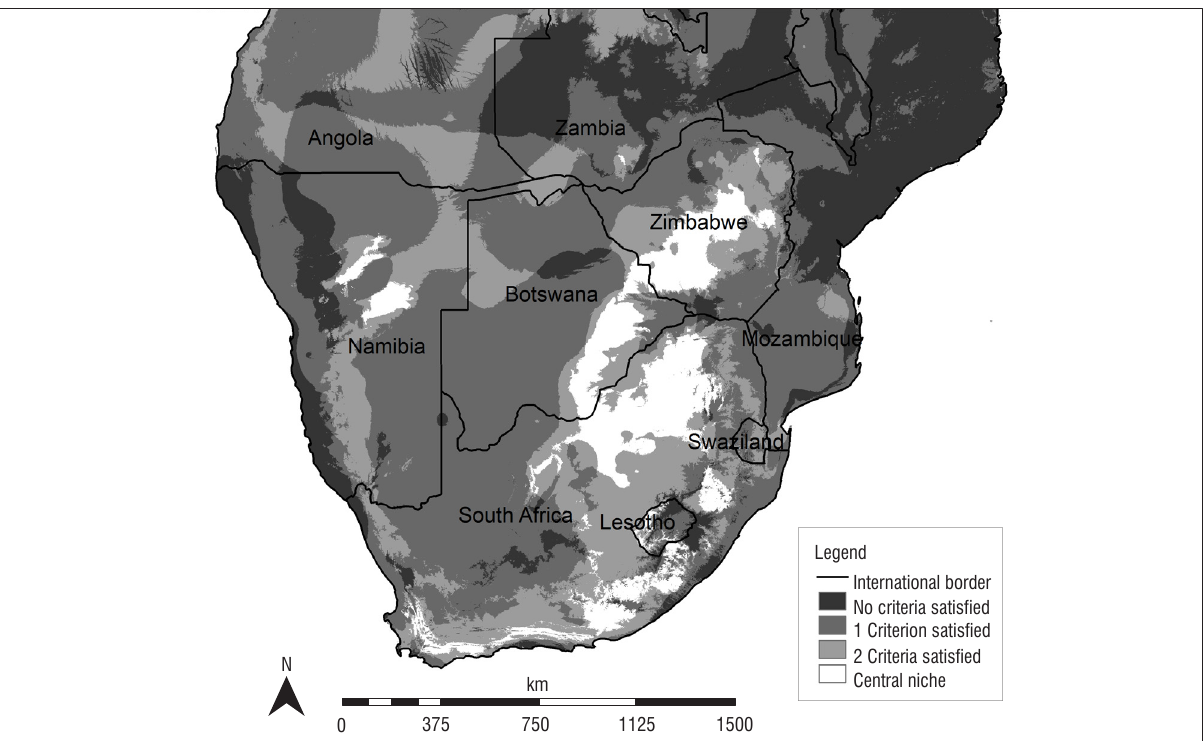
Figure 3: The predicted environmental central niche of the chacma baboon ( Papio ursinus ) in southern